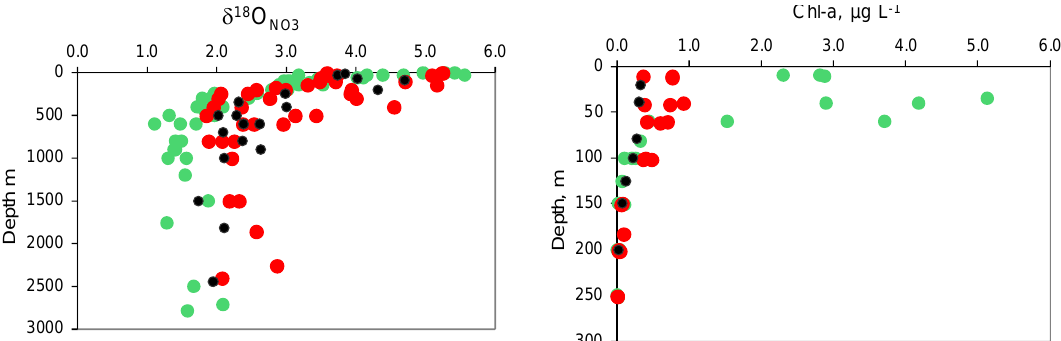
Figure 5. Profiles of δ 18 O NO and Chl a (µgL − 1 ) profile for stations underlying the high chlorophyll plume in the vicinity of the Polar Front 3 (green circles; stations TEW-7, TEW-8, F-L) and in the central part of the Polar Front Meander (red circles; stations TNS-6, TNS-1, TEW-6) and the reference station (black circles; station